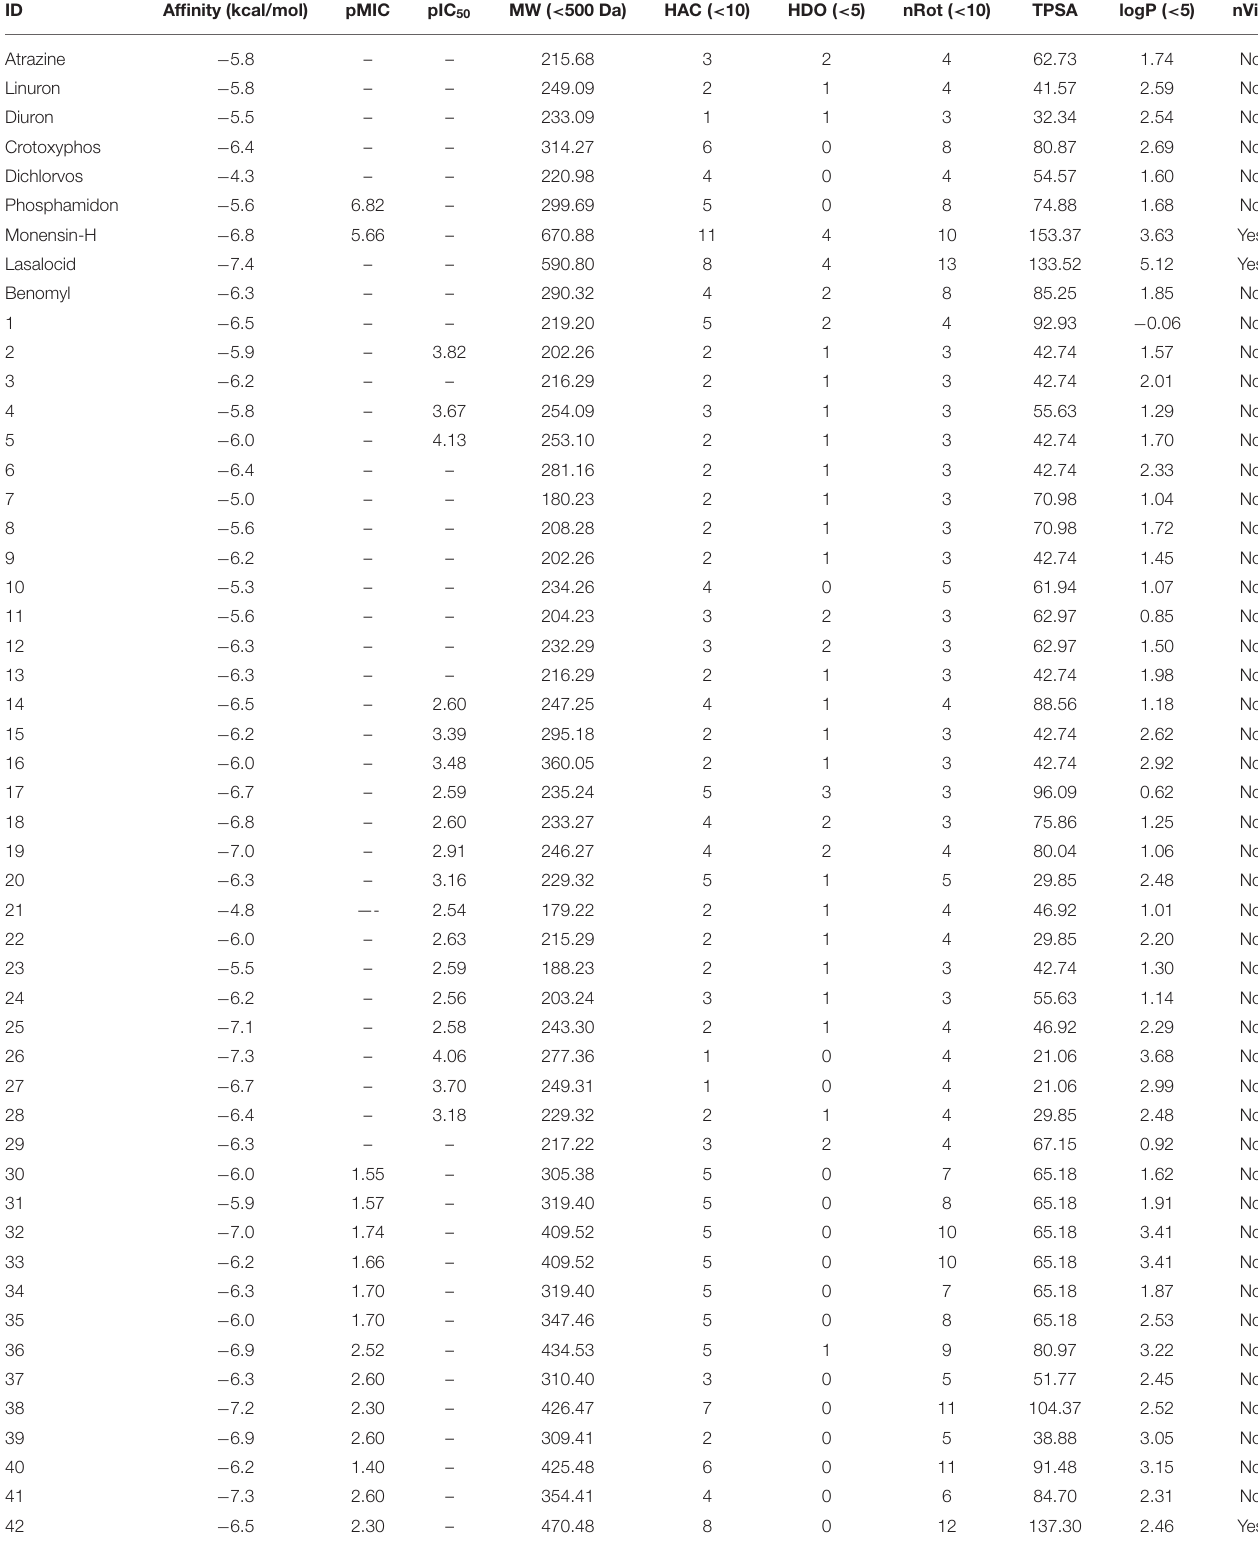
TABLE 7 | pKi, pMIC, pIC50, and ADMET properties of all the dataset